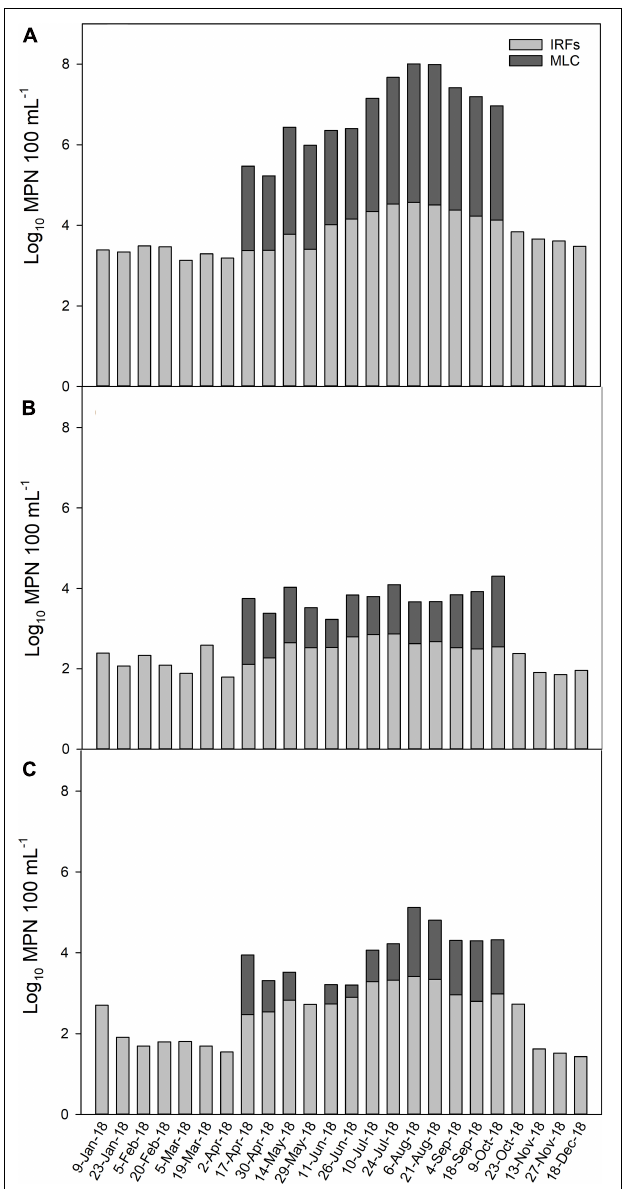
FIGURE 2 | The average level (log 10 MPN 100 mL - 1 ) of (A) total coliform, (B) E. coli , and (C) enterococci in the irrigation return flows (IRFs) and background